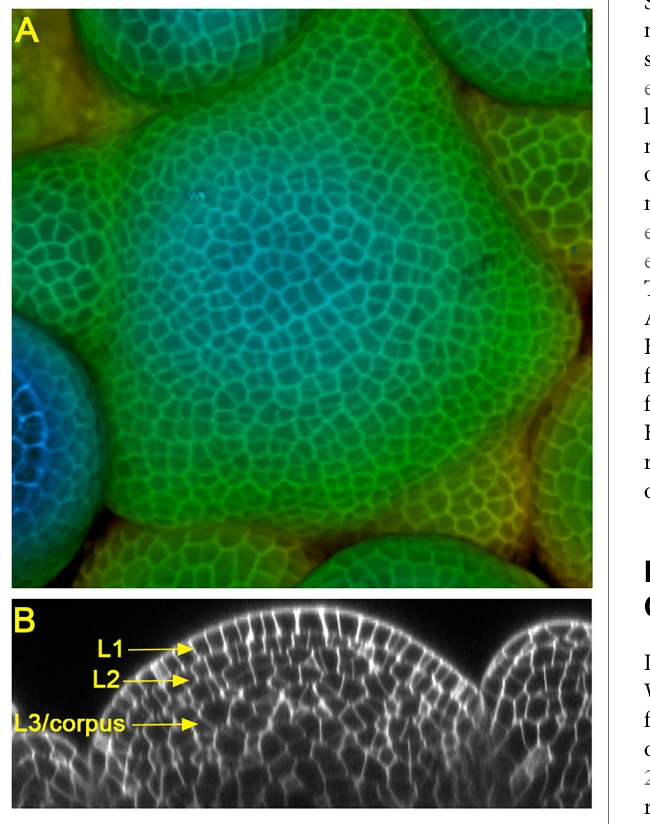
FIGURE 1 | Confocal images of Arabidopsis inflorescence shoot apical meristems (SAMs). (A) The 3D projection view of an Arabidopsis SAM, with the depth color coding. Blue represents the top surface layer and red represents the deepest layer. (B) The orthogonal view of an Arabidopsis SAM, showing three clonally distinct cell layers: the epidermal layer (L1), sub- epidermal layer (L2), and corpus